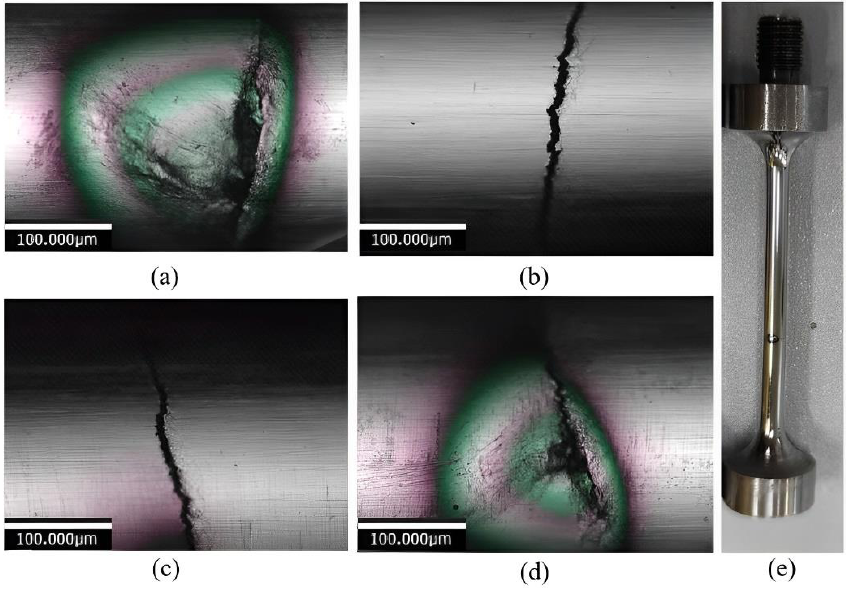
Figure 5. The surface topography of welded joint fatigued specimen ( σ a = 645 MPa, N f = 4.02 × 10 7 cycles): ( a ) and ( d ) burning area, ( b ) and ( c ) crack, ( e ) fatigue specimen.